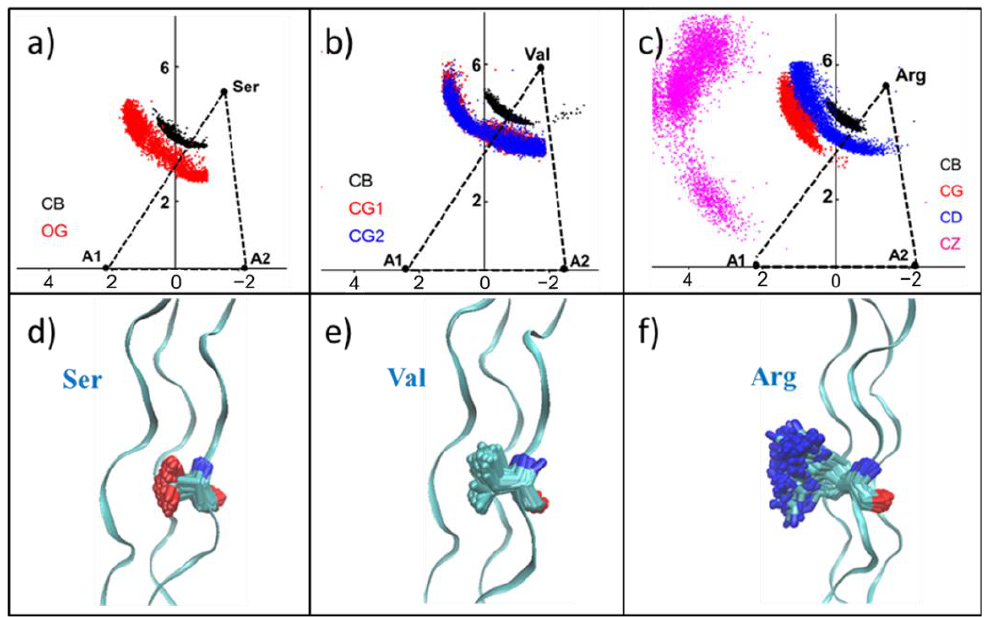
Figure 6. The distribution of mutant amino acid side-chains. ( a – c ) The distribution of heavy atoms in the side-chain in the triangular plane of Ser, Val and Arg. ( d – f ) Cartoon model of mutations with amino acids represented as sticks: oxygen (red), nitrogen (blue), carbon (cyan).